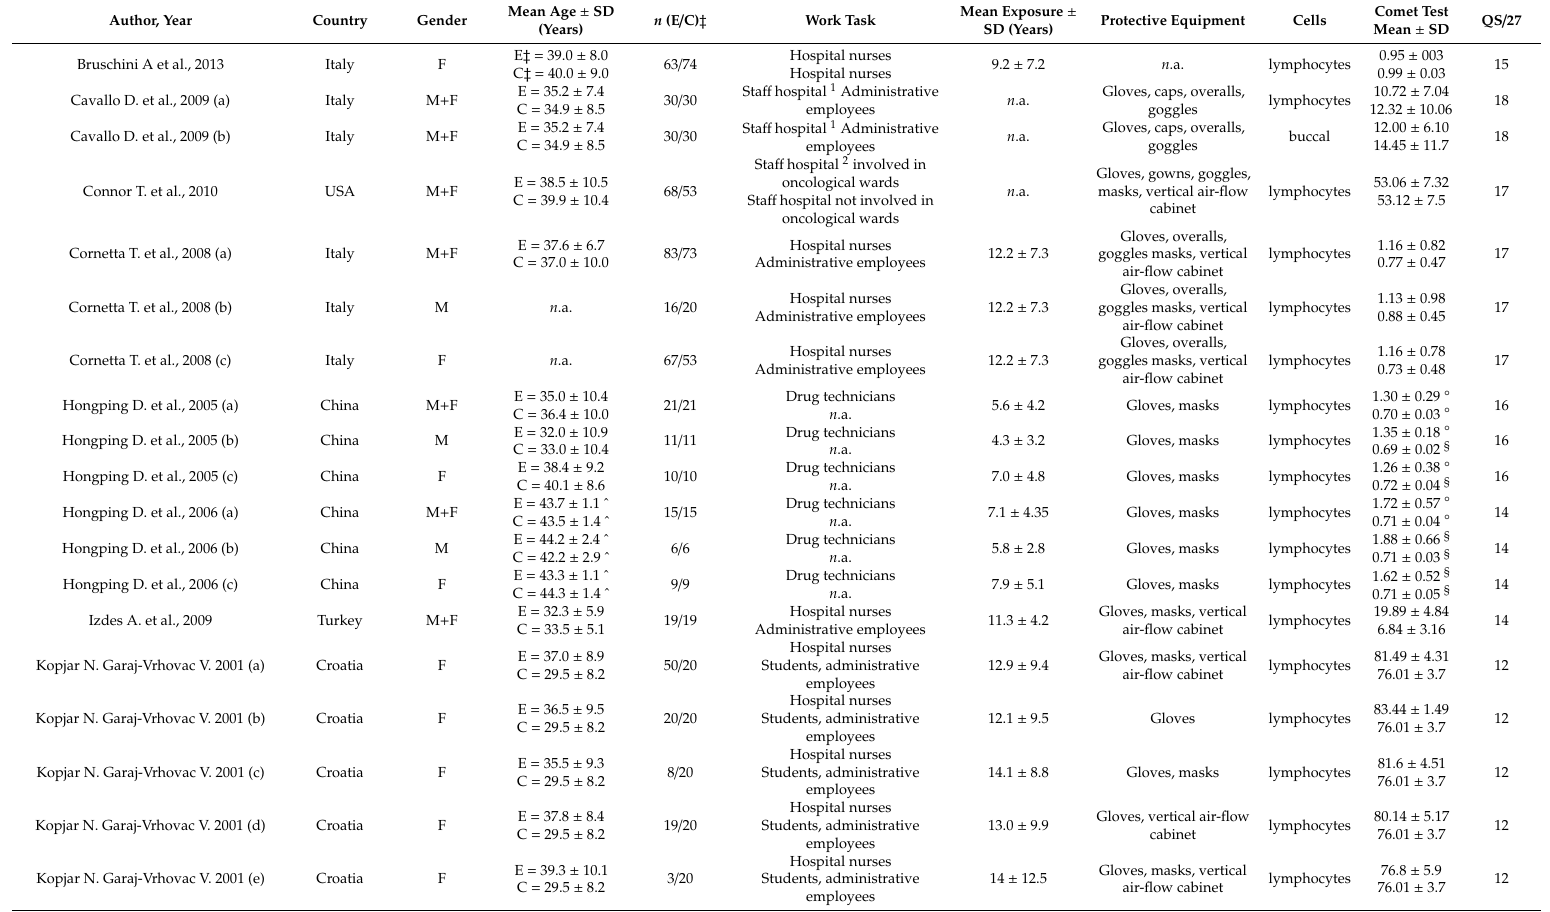
Table 2. Descriptive characteristics of the included